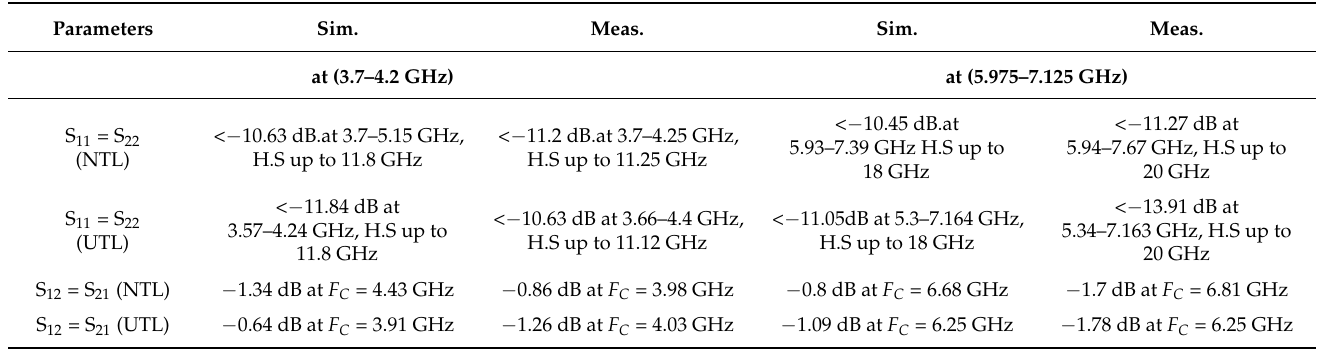
Table 3. Comparison between the simulated and measured results for the designed UTL and NTL